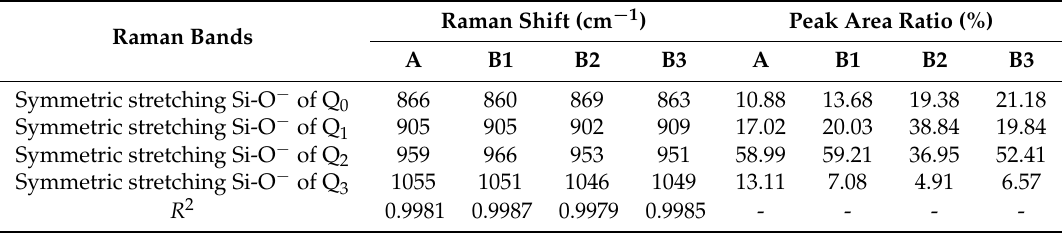
Table 3. Peak analysis of Raman spectra in the mold